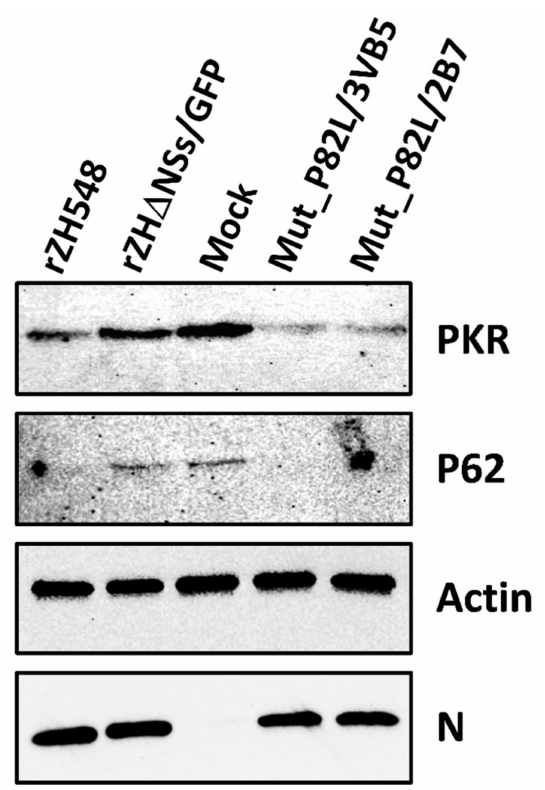
Figure 5. Degradation of protein kinase R (PKR) and p62 in rZH548-P82L infected cells. HEK293T cells were infected at a MOI of 1 with the indicated viruses. Cells were harvested at 20 hpi and analyzed by Western blot using anti-PKR (B-10), anti-p62 (H10) mouse monoclonal antibodies, anti RVFV-N mAb 2B1 and anti-actin antibody as primary antibodies. Samples loaded correspond to 10 6